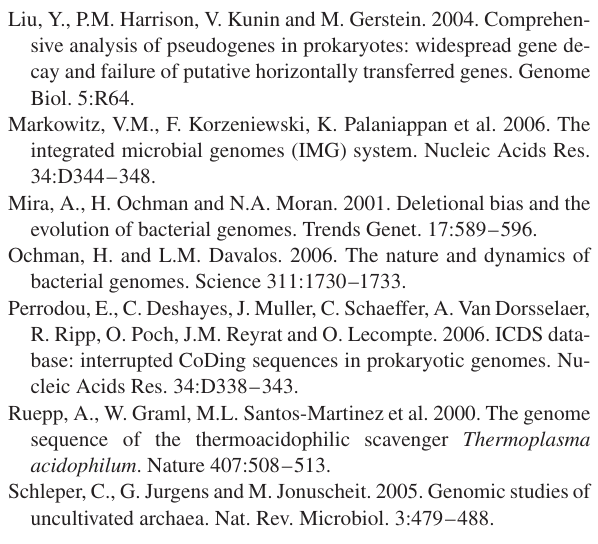
Supplementary Table S1. List of archaeal positional pseudogenes. Available at: